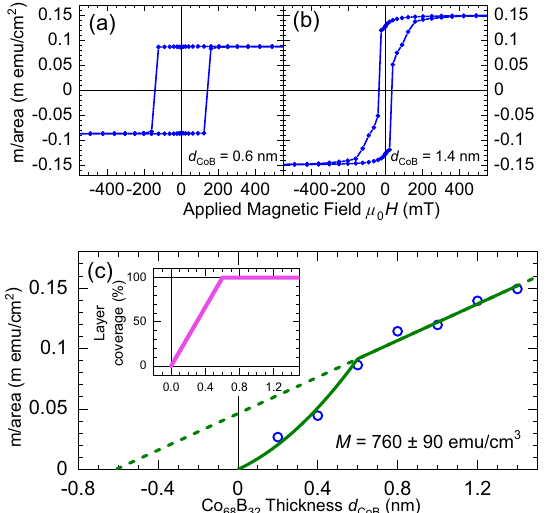
Figure 1. Magnetic characterisation of the sheet film samples S -Pt(10)-Co 68 B 32 ( d CoB )-Pt(5)- S . ( a , b ) Magnetic hysteresis loops of the magnetic moment (m) per area acquired at a temperature of 10 K with the applied field oriented out-of-plane for ( a ) d CoB = 0.6 nm and ( b ) d CoB = 1.4 nm. The diamagnetic contribution from the substrate has been subtracted. ( c ) Collated saturation moment per area versus nominal thickness of Co 68 B 32 . To model the lower m/area of the thinnest samples in the study, we construct a partial layer coverage model detailed in the text and shown in the inset. The result of fitting the model over the entire data range is shown by 3 the solid line. The extracted magnetisation M = 760 ± 90 emu/cm . The dashed line shows an extrapolation of the linear part of the model to the intercepts. Values of m/area are calculated from the measured total magnetic moments and areas of the samples. The uncertainty in each point is dominated by the area measurements, and is less than